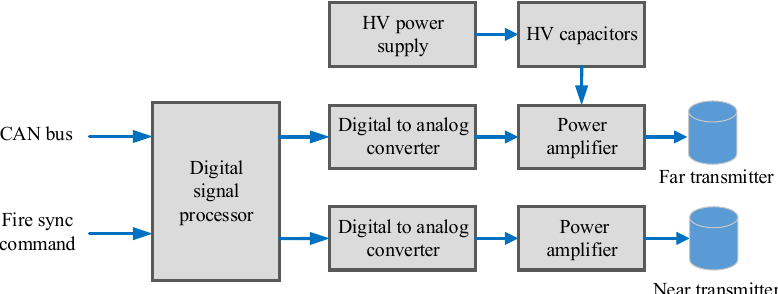
Figure 6. Schematic diagram of the dual ‐ source excitation circuit.